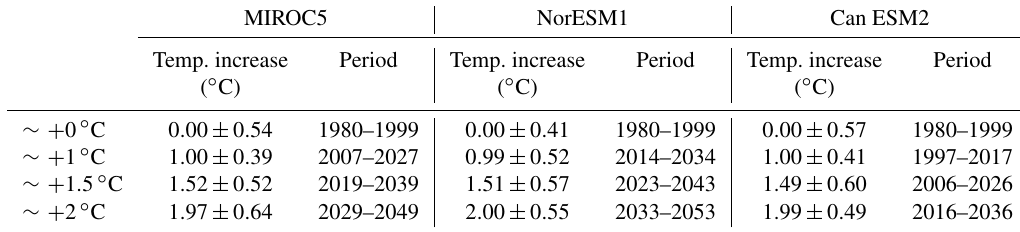
Table 1. The 20-year periods corresponding to an increase in temperature of ∼ + 1, ∼ + 1 . 5, and ∼ + 2 ◦ C for the three selected GCMs (MIROC5, NorESM1, and CanESM2). The exact increase in temperature and the standard deviation for these periods compared with 1980– 1999 are shown. MIROC5 NorESM1 Can ESM2 Temp. increase Period Temp. increase Period Temp. increase Period ( ◦ C) ( ◦ C) ( ◦ C) ∼ + 0 ◦ C 0 . 00 ± 0 .